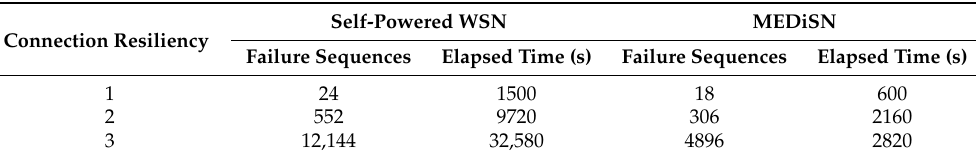
Table 6. Reasoning time of the ADVISES Tool for a self-powered WSN and MEDiSN considering a threshold value equal to